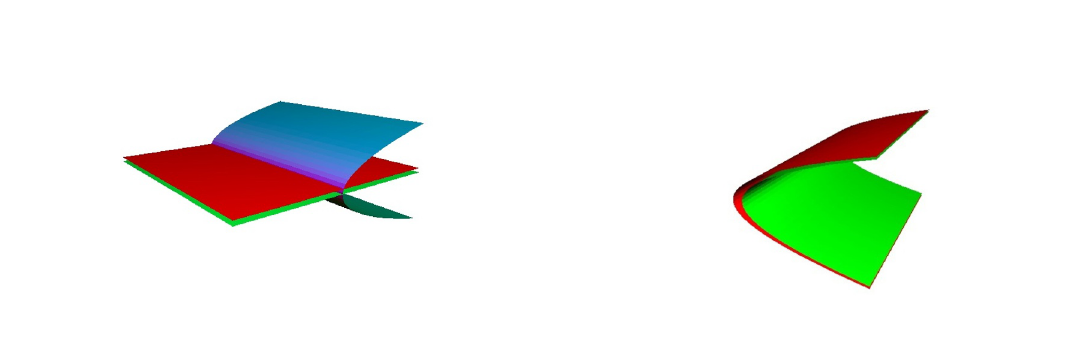
Figure 9 . Non-reduced degree four spectral